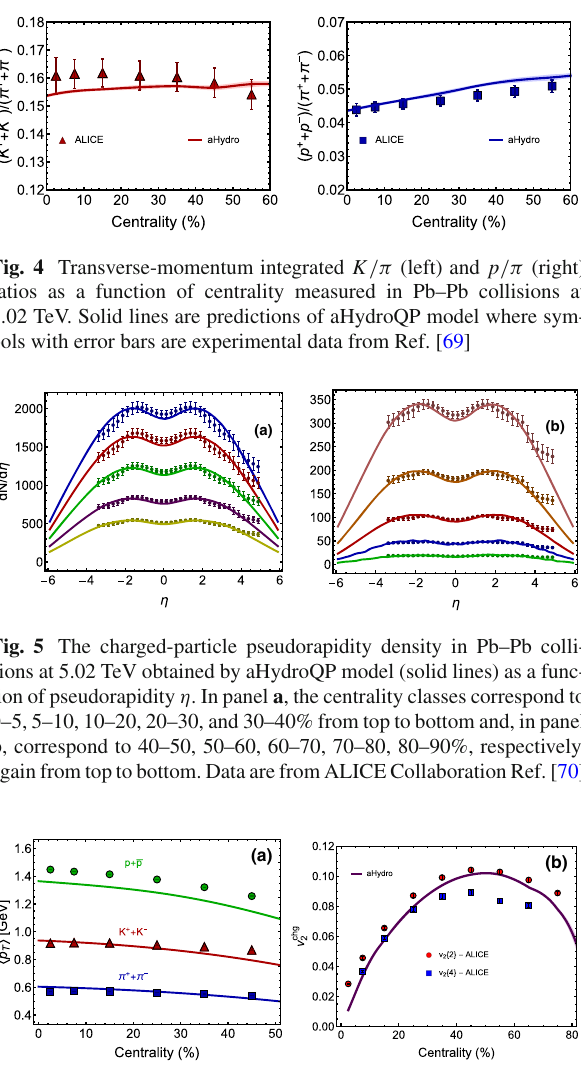
Fig. 6 In panel a , identified particle mean transverse momentum vs. centrality is shown in 5.02 TeV Pb+Pb collisions where data are from ALICE Collaboration Ref. [69], while in panel b , the centrality depen- dence of the elliptic flow v 2 of charged particles in 5.02 TeV Pb–Pb collisions is shown where data are from Ref.